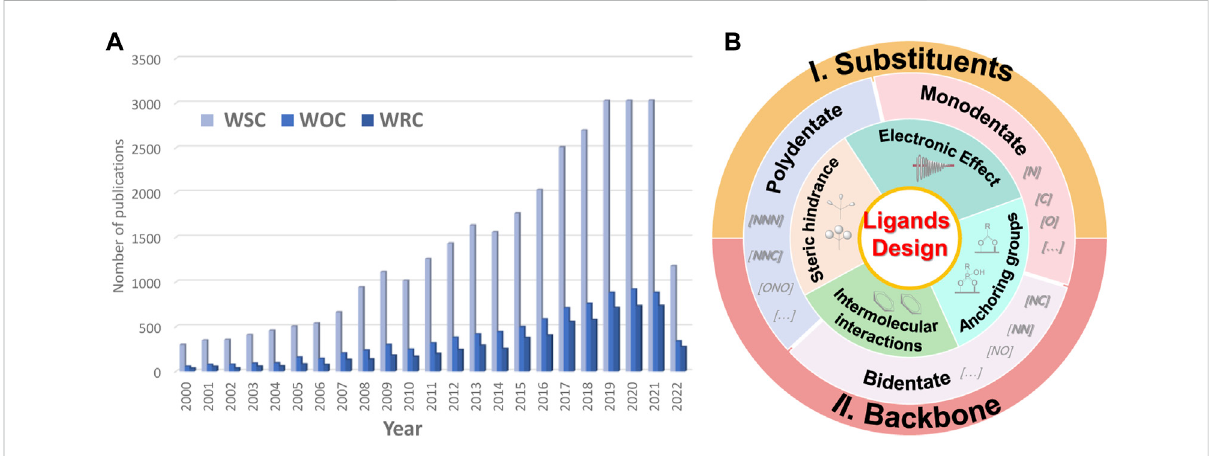
FIGURE 2 (A) Number of published papers related to molecular catalysts for water splitting from 2000 to 2022 (data obtained on 30 July 2022, from a search performed in the Web of Science for “ molecular water splitting* “ , “ molecular water oxidation* “ , and “ molecular water reduction* ” topics). (B) Designing strategies of ligands for molecular water splitting